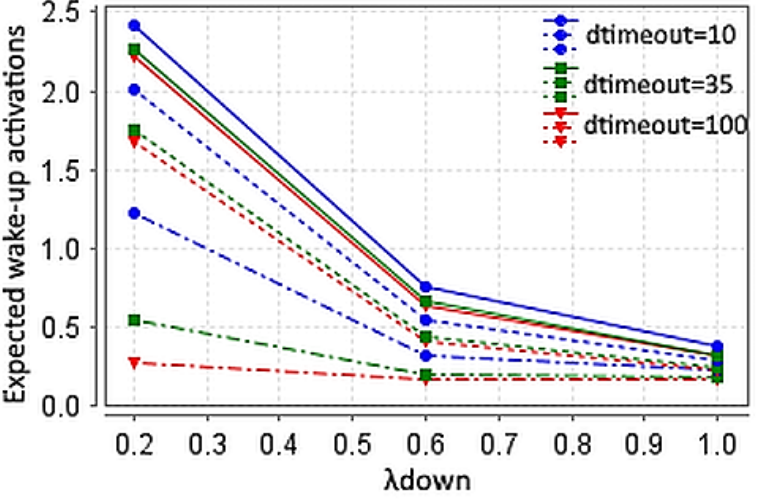
Figure 9. The expected number of times the wake-up mechanism activates for different d timeout and different r fk values. r fk = 0 (solid line), r fk = 0.5 (dotted line), and r fk = 1 (dashed